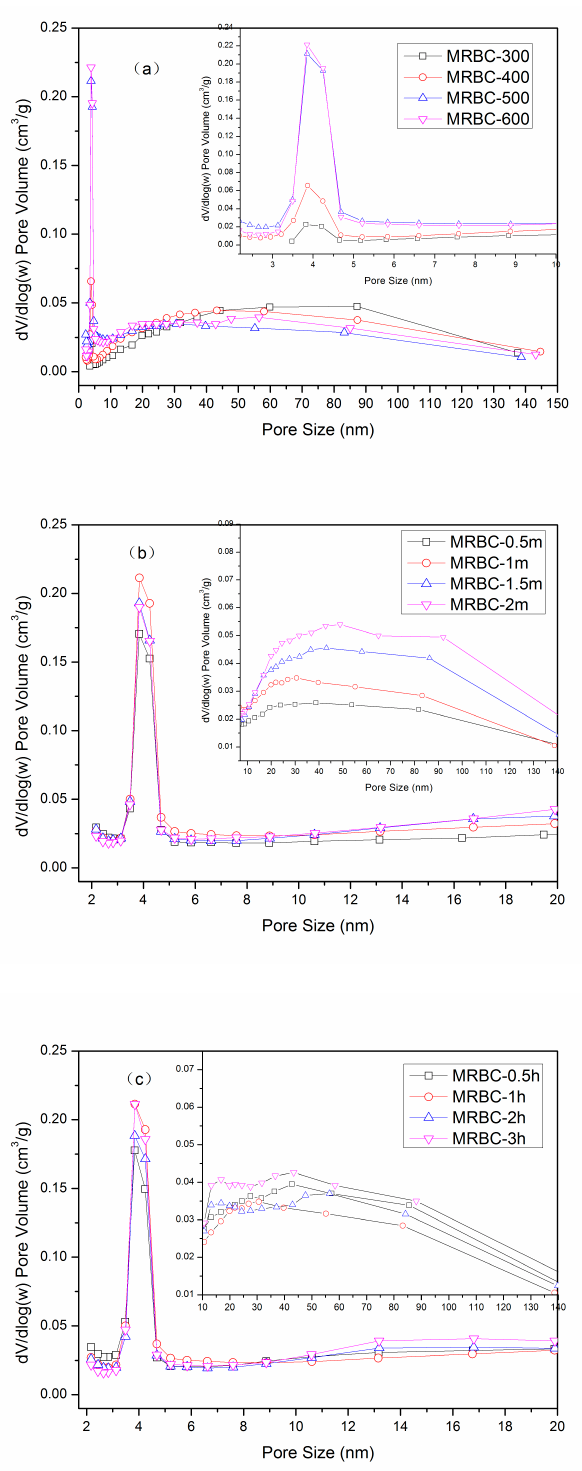
Figure2. Poresizedistributionofbiocharpreparedunderdi ff erentconditions: ( a )pyrolysistemperature; Figure 2. Pore size distribution of biochar prepared under different conditions: ( a ) pyrolysis ( b ) MgCl 2 impregnation concentration; ( c ) pyrolysis temperature; ( b ) MgCl 2 impregnation concentration; ( c ) pyrolysis time.